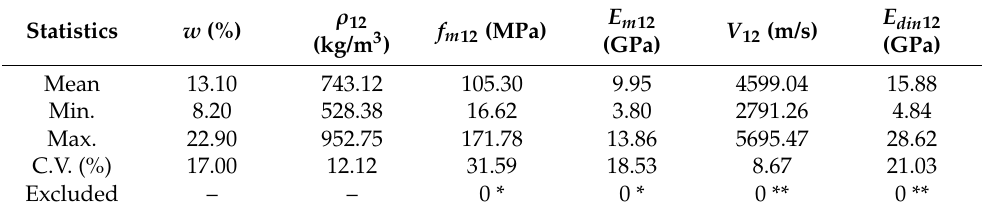
Table 3. Values of moisture content ( w ) and values of the sample corrected for wood moisture content of 12% (density ( ρ 12 ), bending strength ( f m 12 ), modulus of elasticity in bending ( E m 12 ), velocity of transmission of the wave ( V 12 ), dynamic modulus of elasticity ( E din 12 )) using ISO 3130 [25], ISO 3133 [23] and EN 384